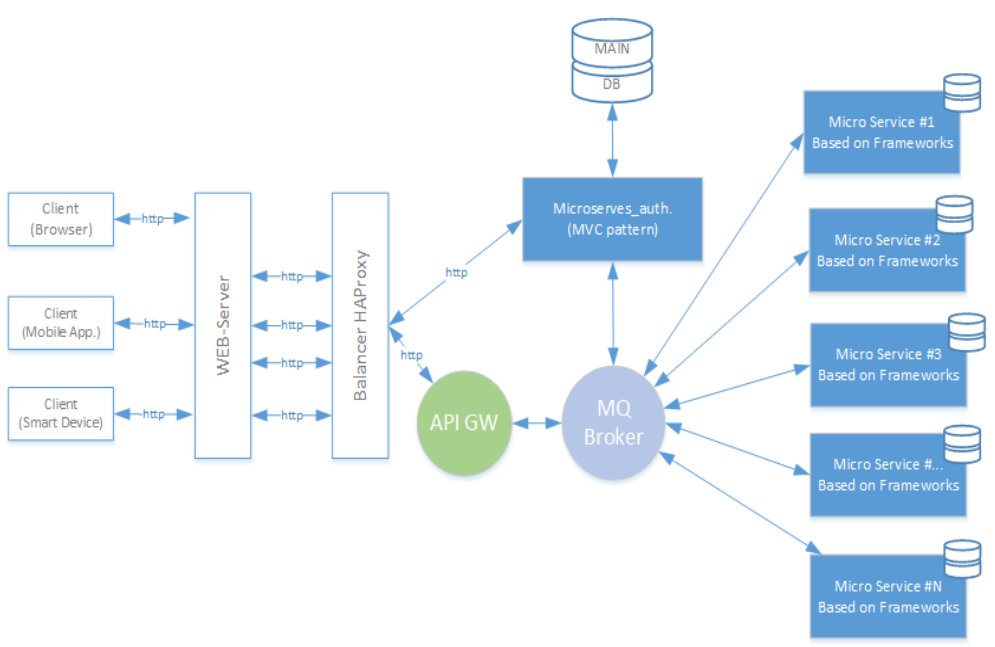
Figure 3. Typical microservice high-level functional architecture of the